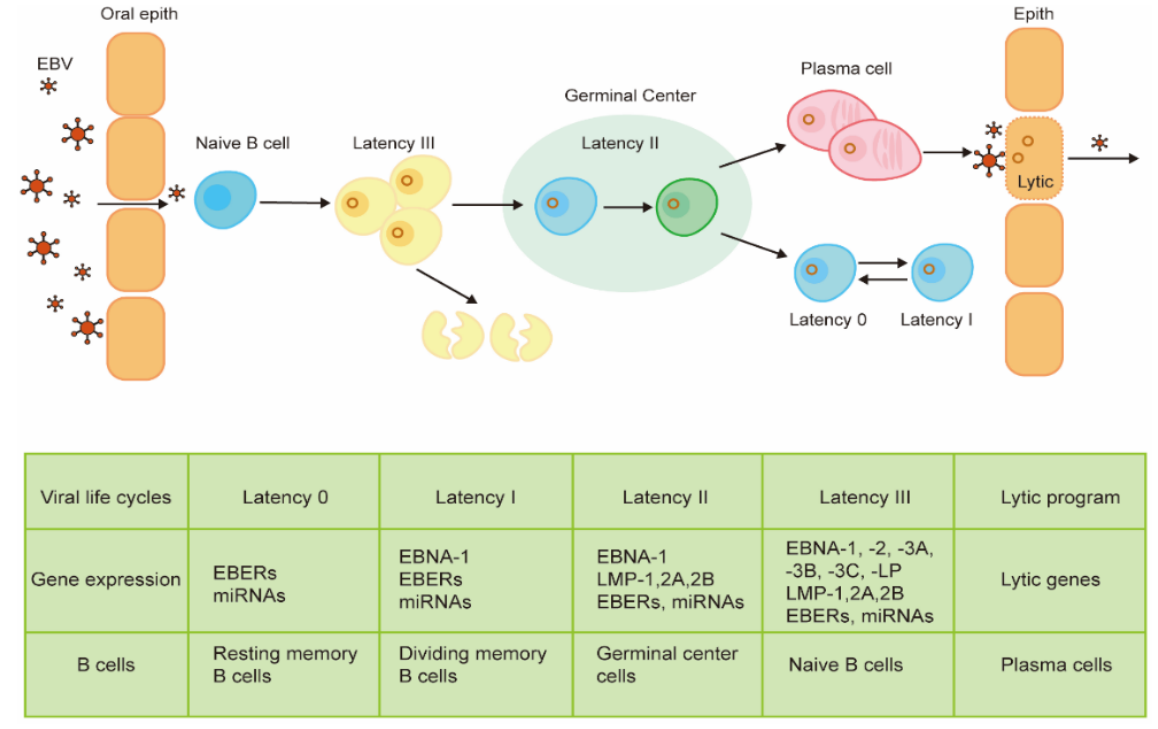
Figure 1. Progress and distinguished gene expression profiles of B cells infected by EBV. The germinal center model is the widely held model to show how the virus enters memory B cells. Orally acquired virus particles may initially infect oropharyngeal B cells, resulting in EBV-transformed B cell growth through a growth program by expressing all the viral proteins (latency III), including EBNA1, EBNA2, EBNA3A-3C, EBNA-LP, LMP1, LPM2A, and LMP2B. Being highly immunogenic, these cells can be recognized and rapidly eliminated by host immunity. Then, the virus-infected B cells go through a physiologic germinal center reaction, by limiting protein expression of latency II (EBNA1, LMP1, LMP2A, and LMP2B). After that, B cells leave the germinal center and enter the memory B cell pool by shutting down all the viral genes (latency 0). When the viral genome replicates along with the cell, EBV-infected memory B cells need to express EBNA1 (latency I). The latently infected memory B cells occasionally reactivate and differentiate into plasma cells, which is associated with the initiation of the lytic program and production virions.